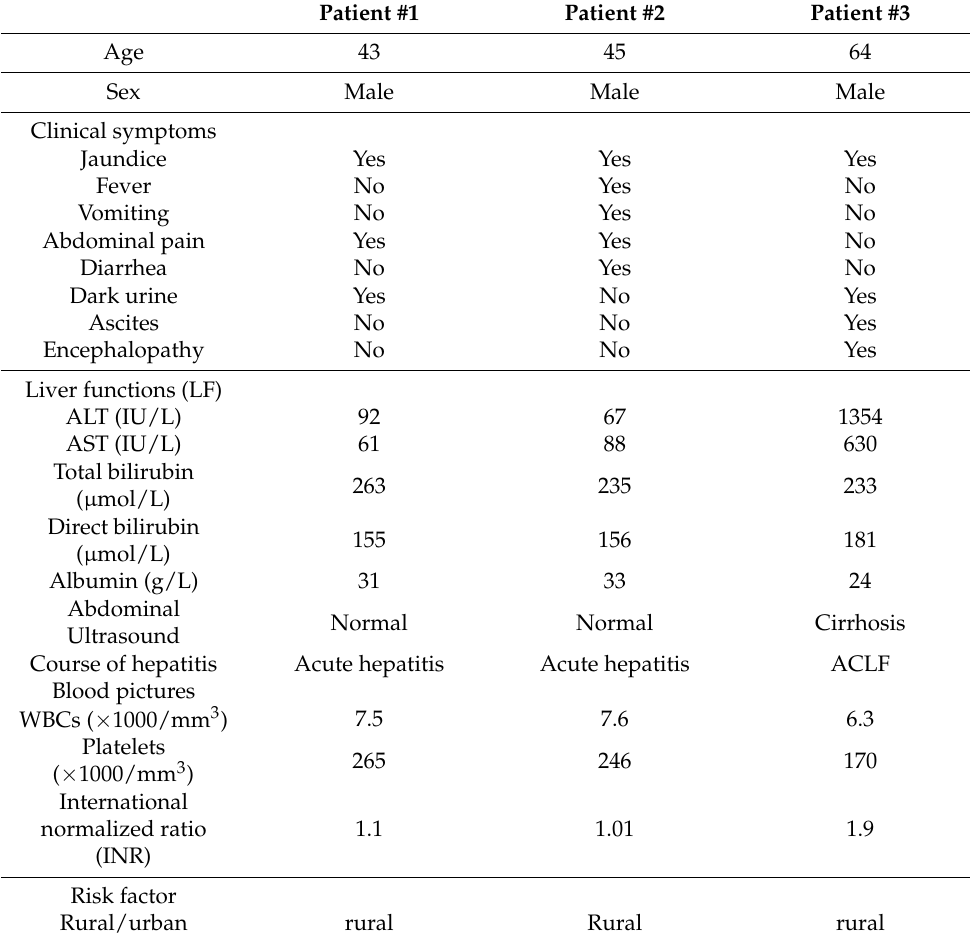
Table 2. Demographic, clinical, and laboratory criteria of acute Q-fever